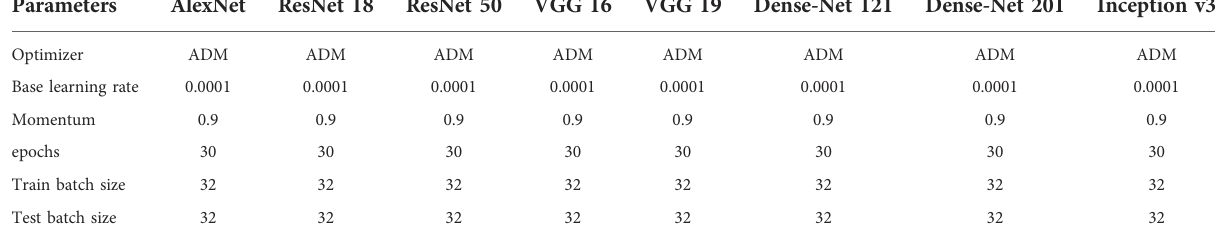
TABLE 2 The setting of parameters for CNN